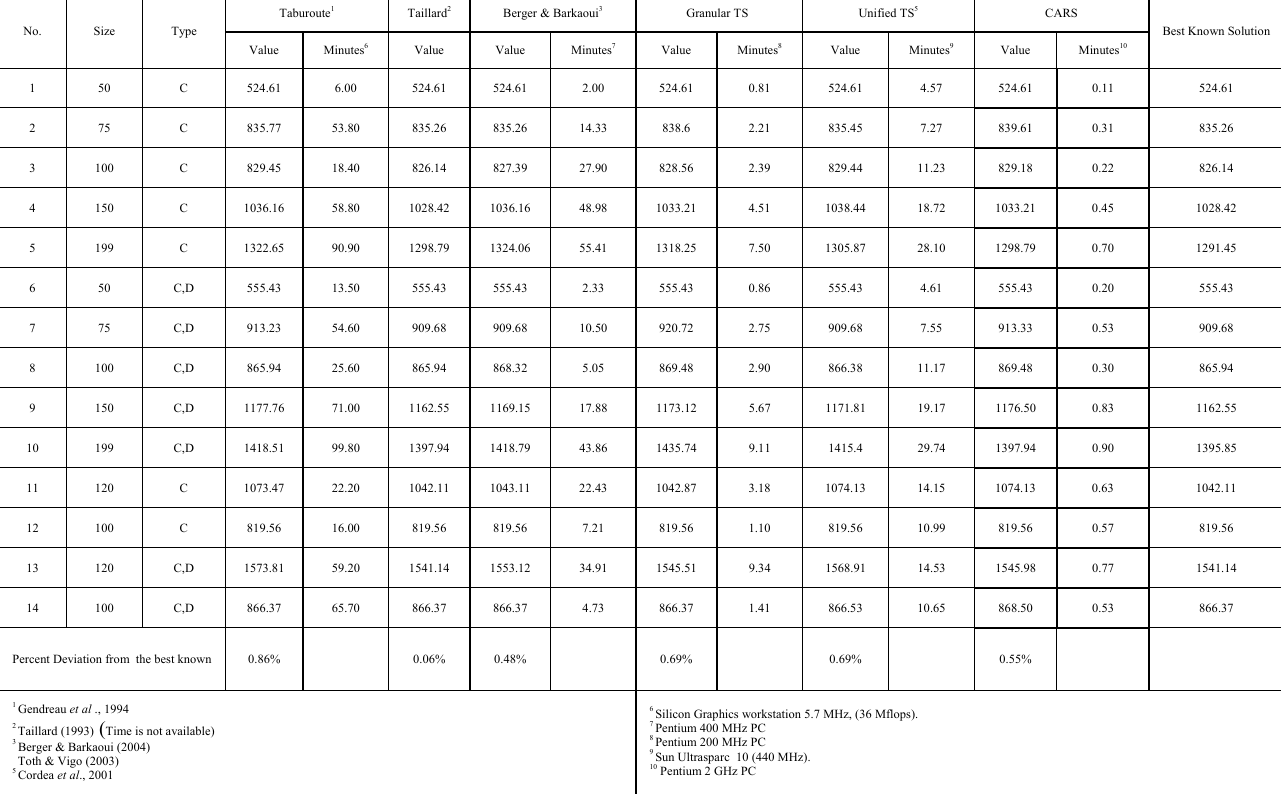
Table 2: Comparison of CARS' results for the selected algorithms on CMT benchmark instances